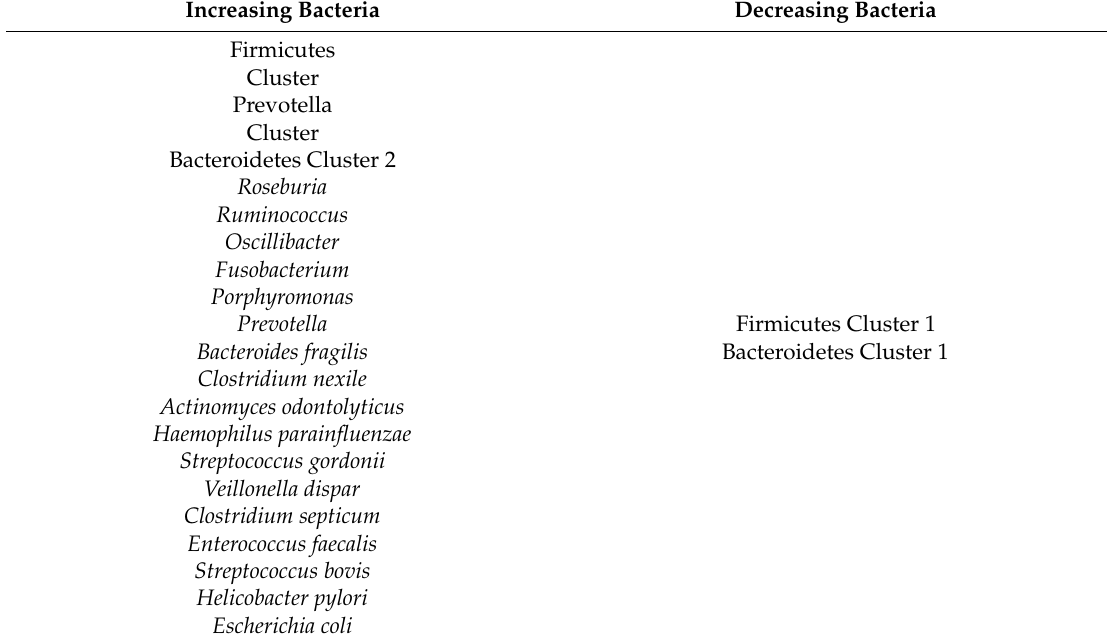
Abbreviation: CRC—colorectal